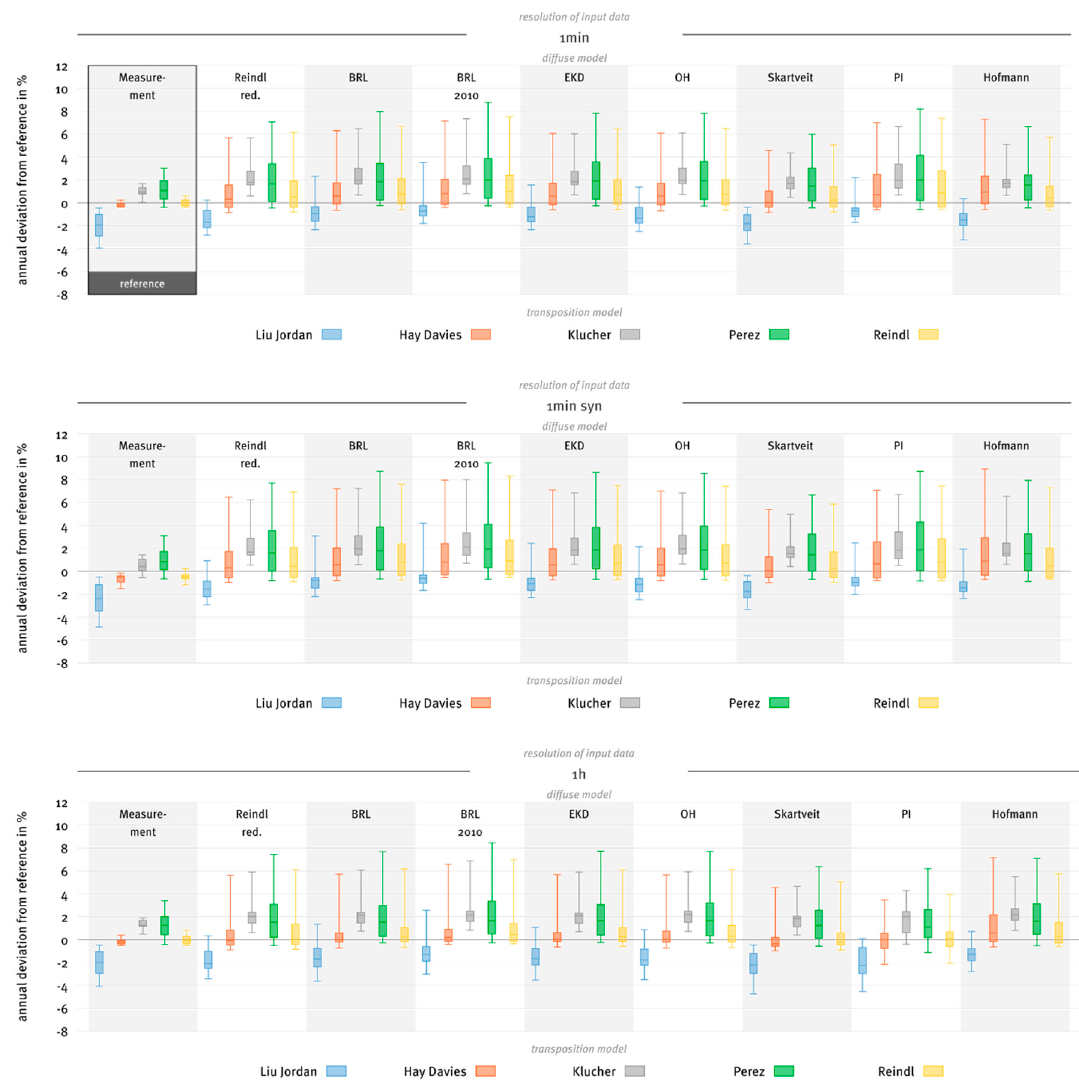
Figure 8. The annual deviation of the modeled PV energy from the reference model chain, grouped by diffuse fraction model, transposition model and input data type. The reference is calculated from the output of the model chains that contain one-minute measurement data for both global and diffuse irradiation (black frame). Each box and whisker contains results from 30 locations. Here, only the results of the optimal tilt mode are displayed. See Appendix A Figures A1–A4 for other tilt modes and overall results.